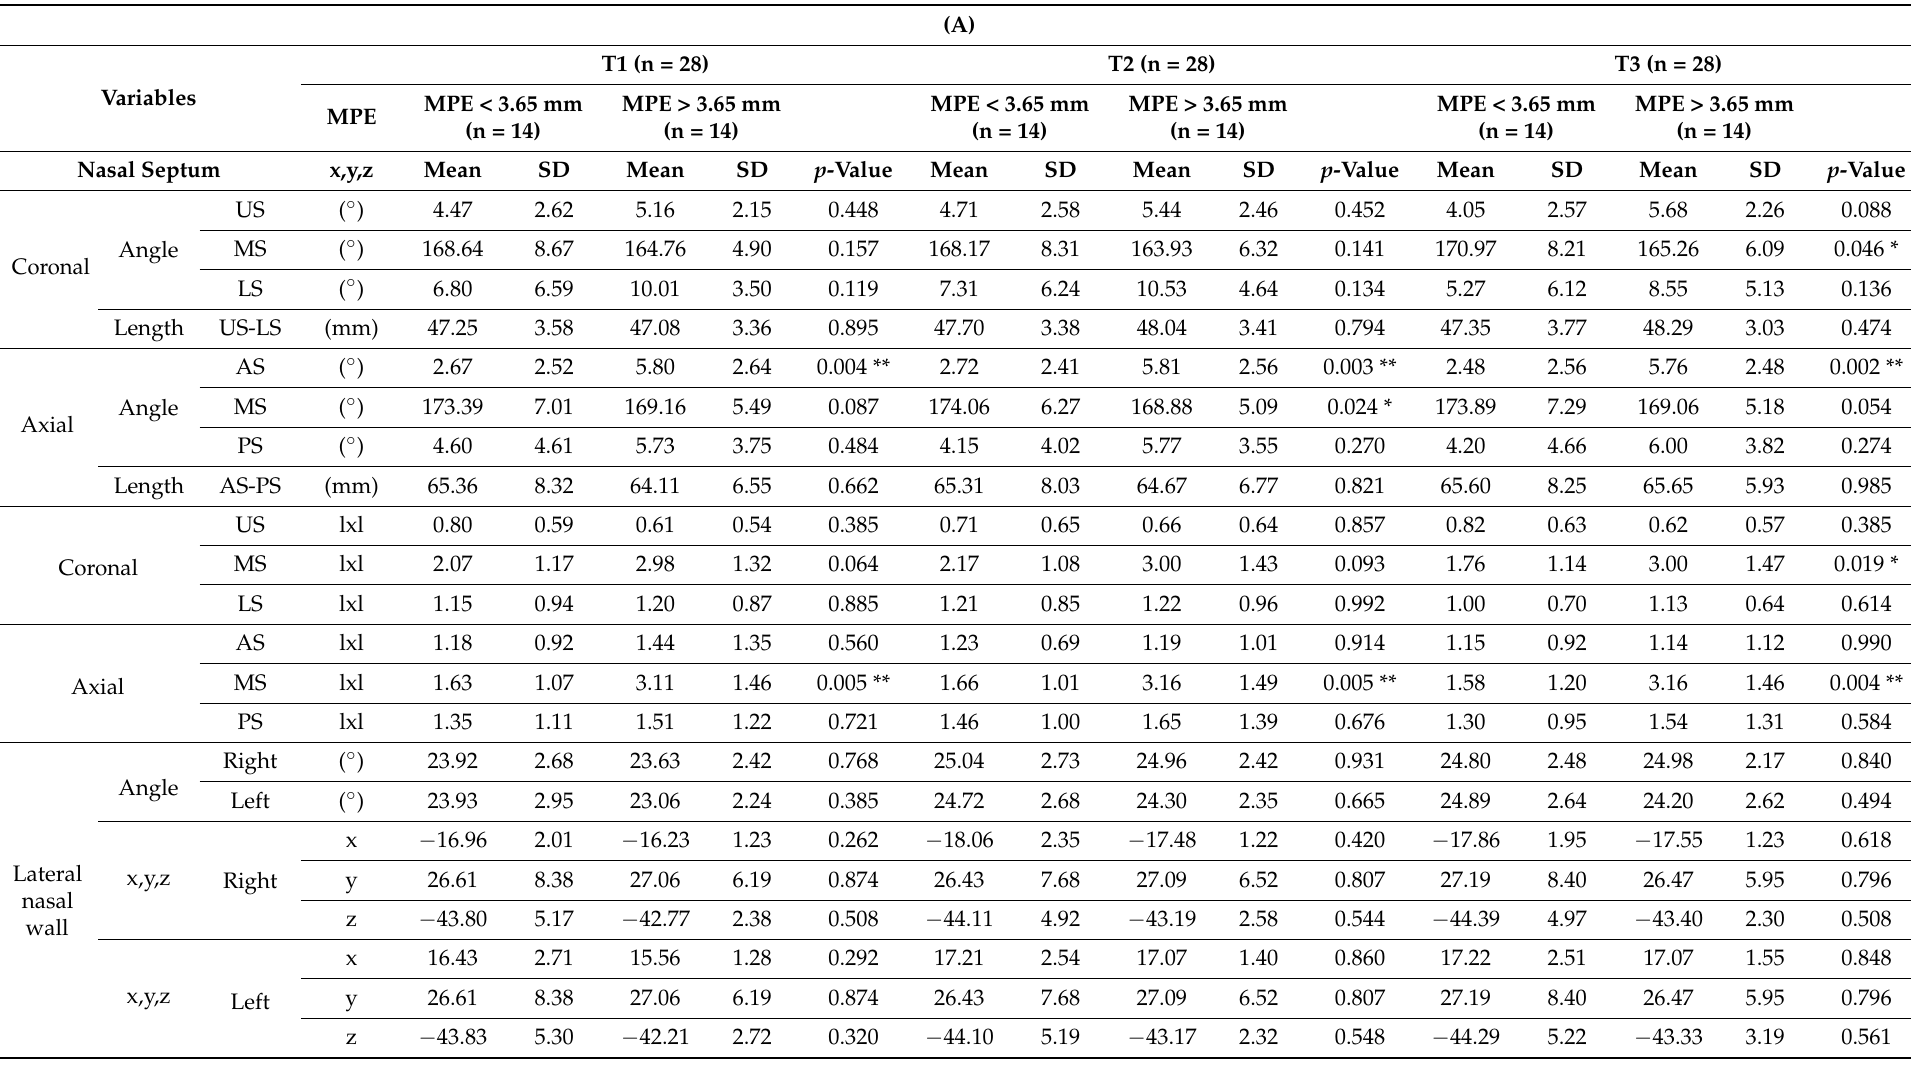
Table 6. Three-dimensional values (A) and changes (B) of nasal septum and nasofacial structures after MSE depending on the amount of midpalatal